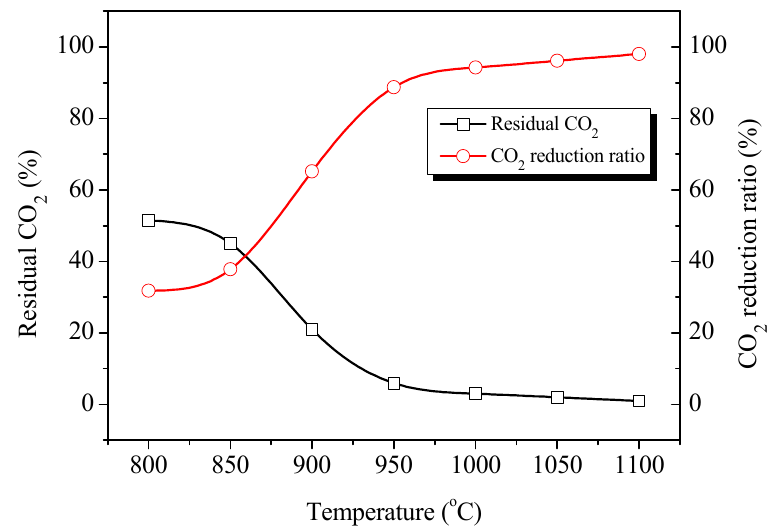
Figure 1. The carbon dioxide reactivity of experimental coal.